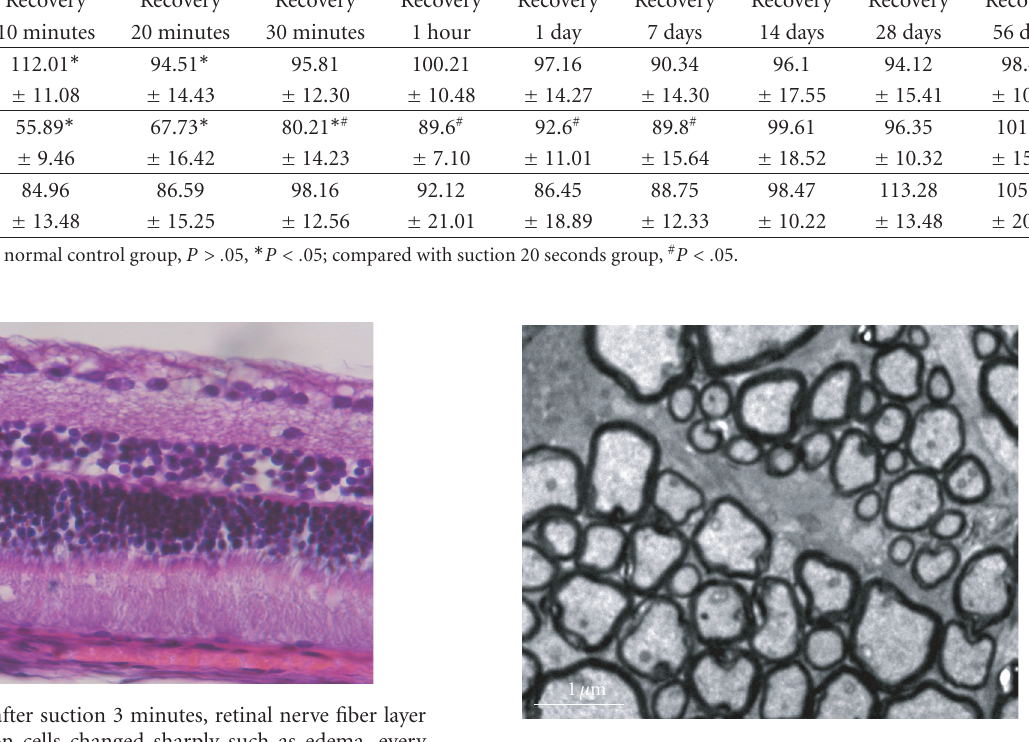
Figure 3: The normal fiber marrow scabbard of the optic nerve is tightness, no delamination ( × 10